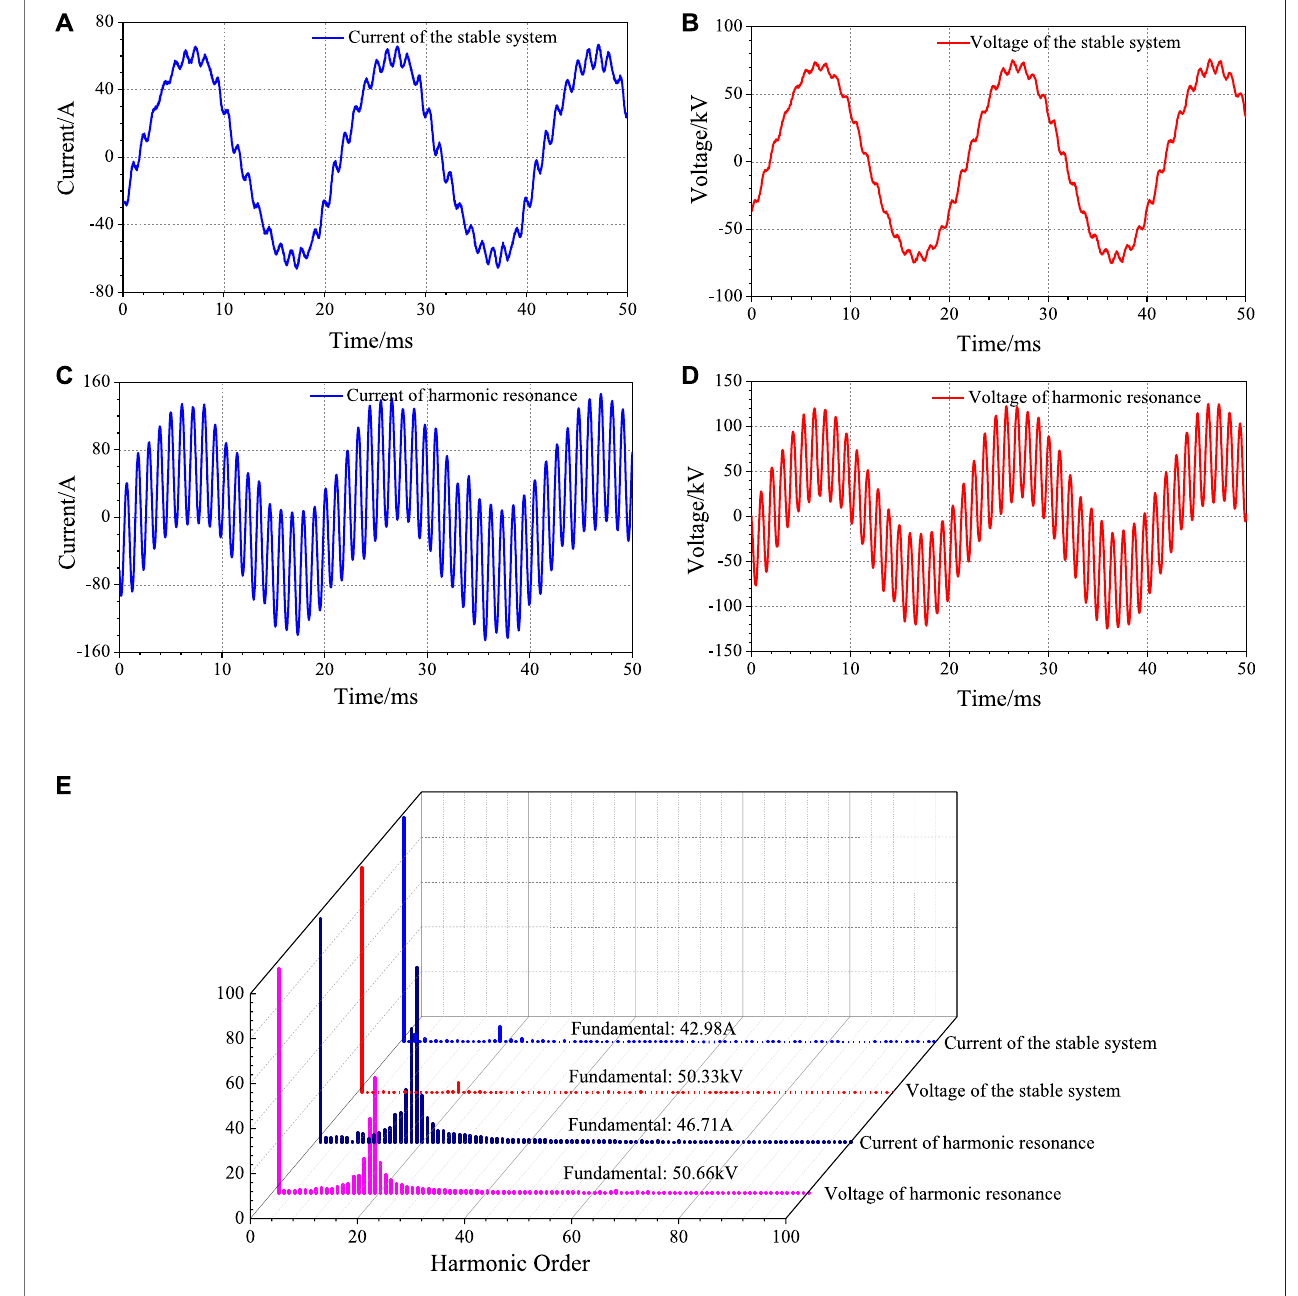
FIGURE2| Thewaveformsofcurrentandvoltage (A) currentofthestablesystem (B) voltageofthestablesystem (C) currentofharmonicresonance (D) voltageof harmonic resonance. (E) The harmonic spectra of the current and voltage.